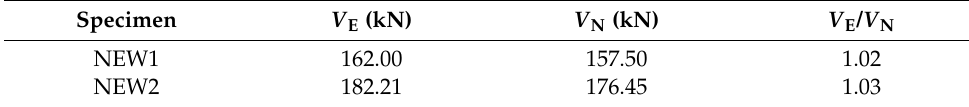
Table 8. Comparisons between test results and numerical simulation results.